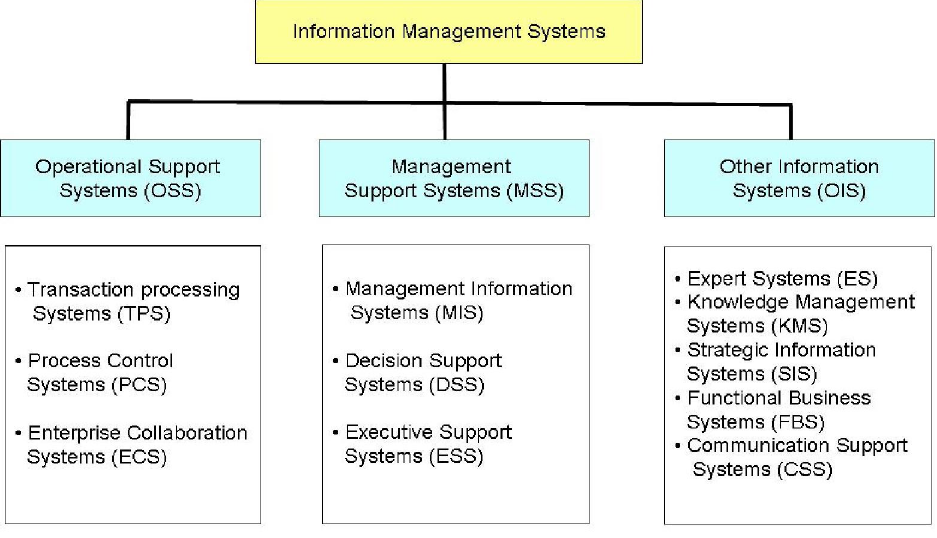
Fig. 1. Hierarchy of Information Systems applicable to ODL